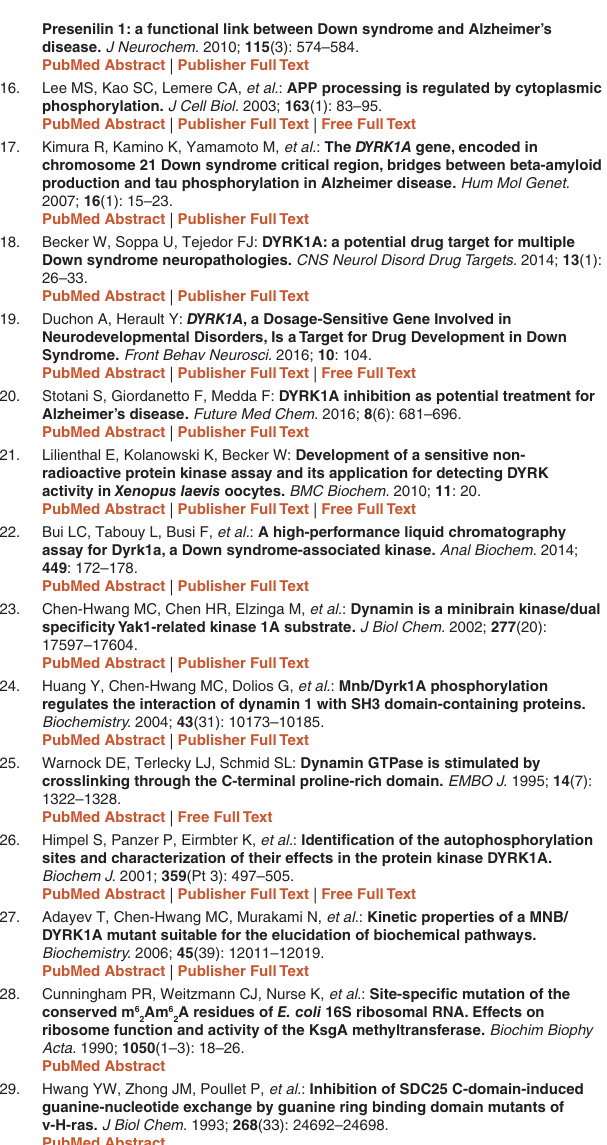
Supplementary Figure. Secondary antibody dilution factor determination. Phosphorylated HT-PRD in ELISA wells were prepared and probed with 3D3 (1:3000 dilution) followed by serially diluted secondary antibody (from 1000 to 256,000x) similarly as described in Figure 5. Like 3D3 titering, normalized OD was calculated for plotting (n = 6 for each data point). 405 Click here to access the data. Supplementary Table. Estimation of Z’-factor for the ELISA assay performed under standard conditions. Click here to access the